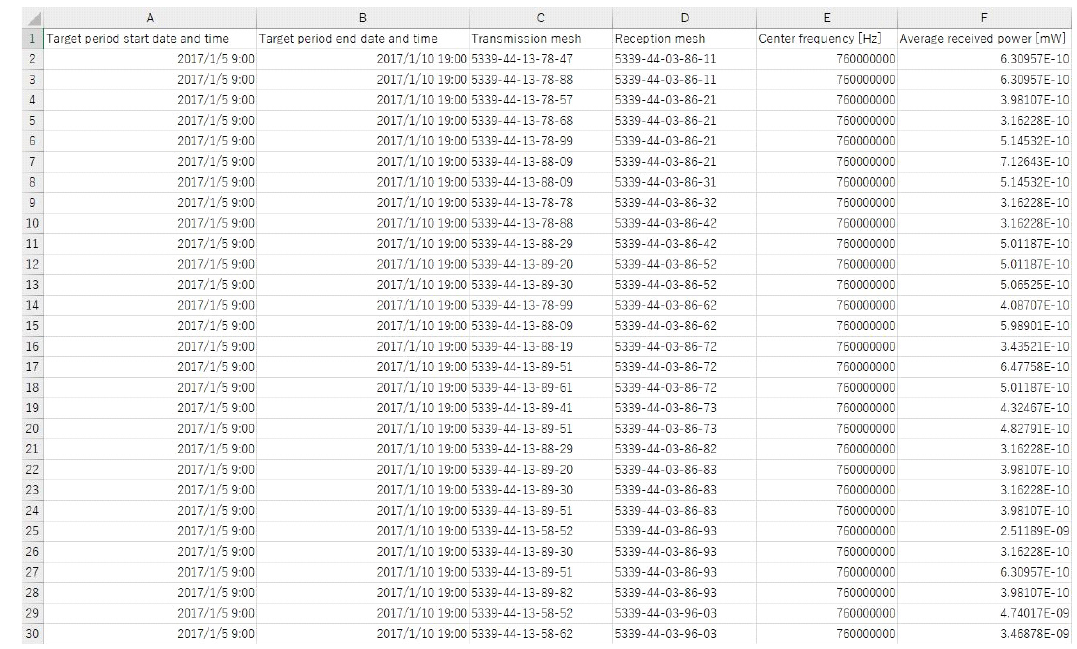
Figure 6. Example of the statistical